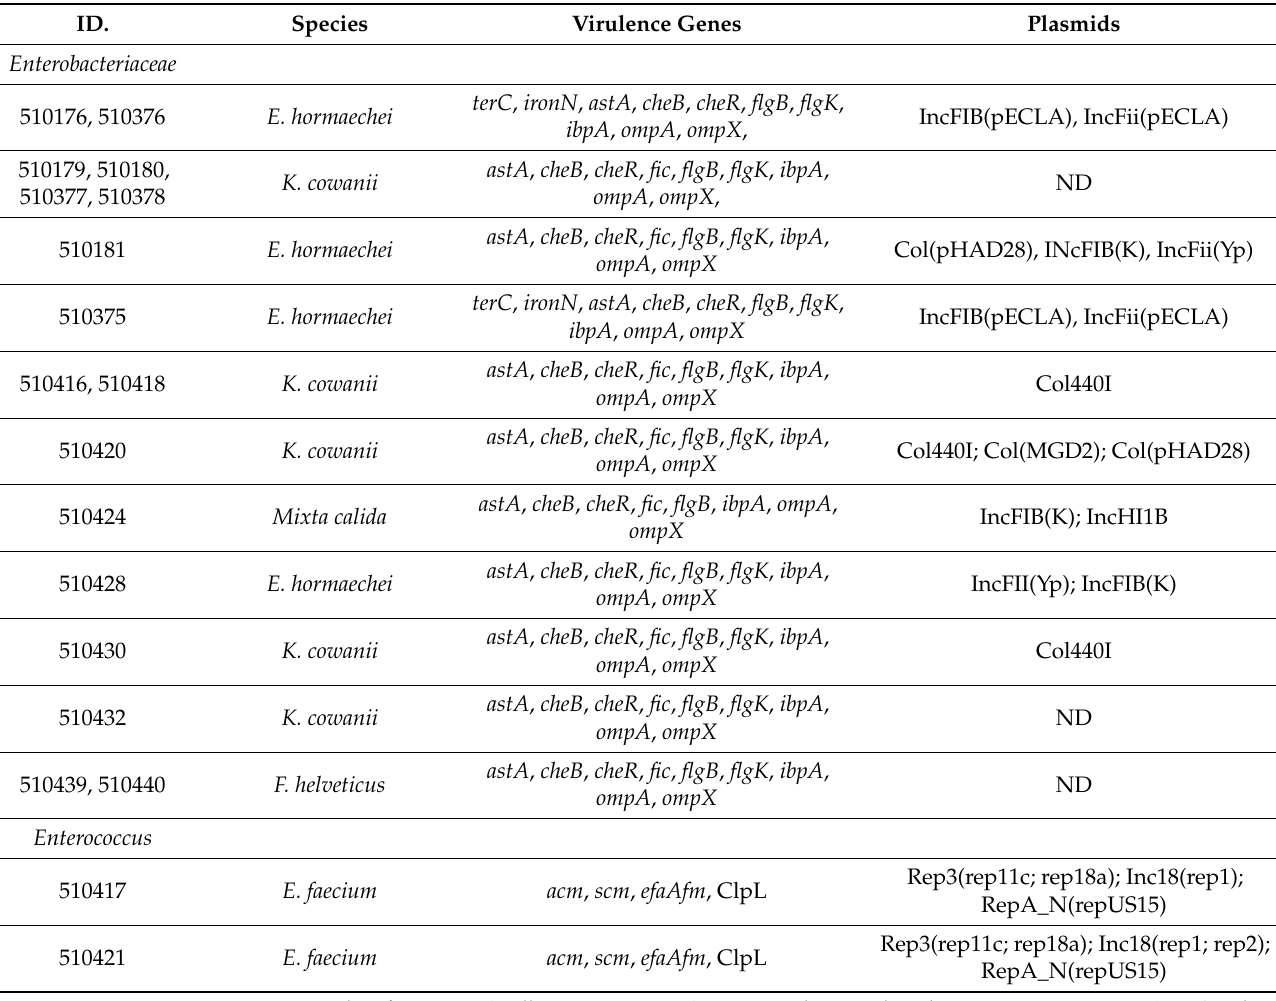
Table 4. Presence of virulence genes and plasmids within the strains under